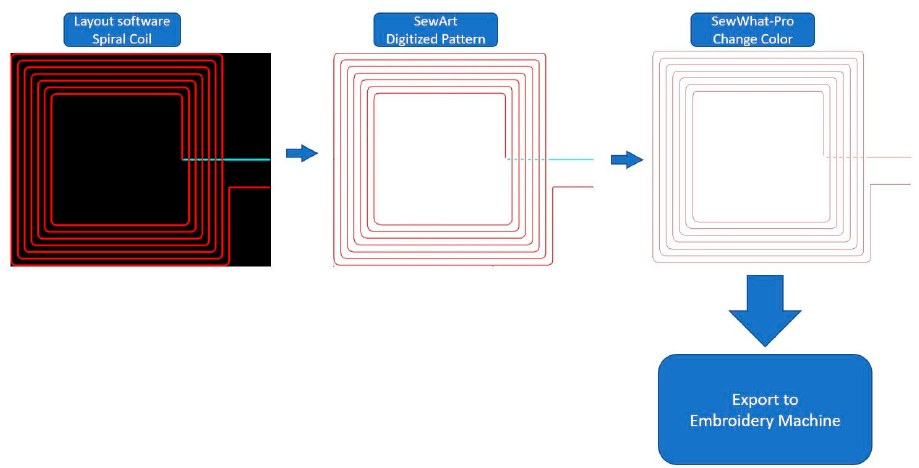
Figure 2. Process of creating embroidery file of an RX coil with a crossover stripe.